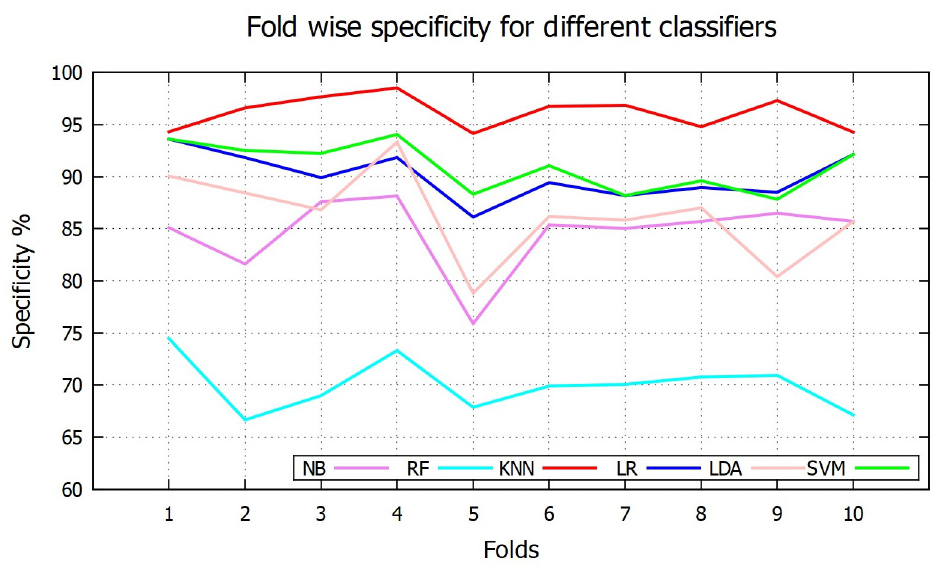
Fig 8. Fold wise